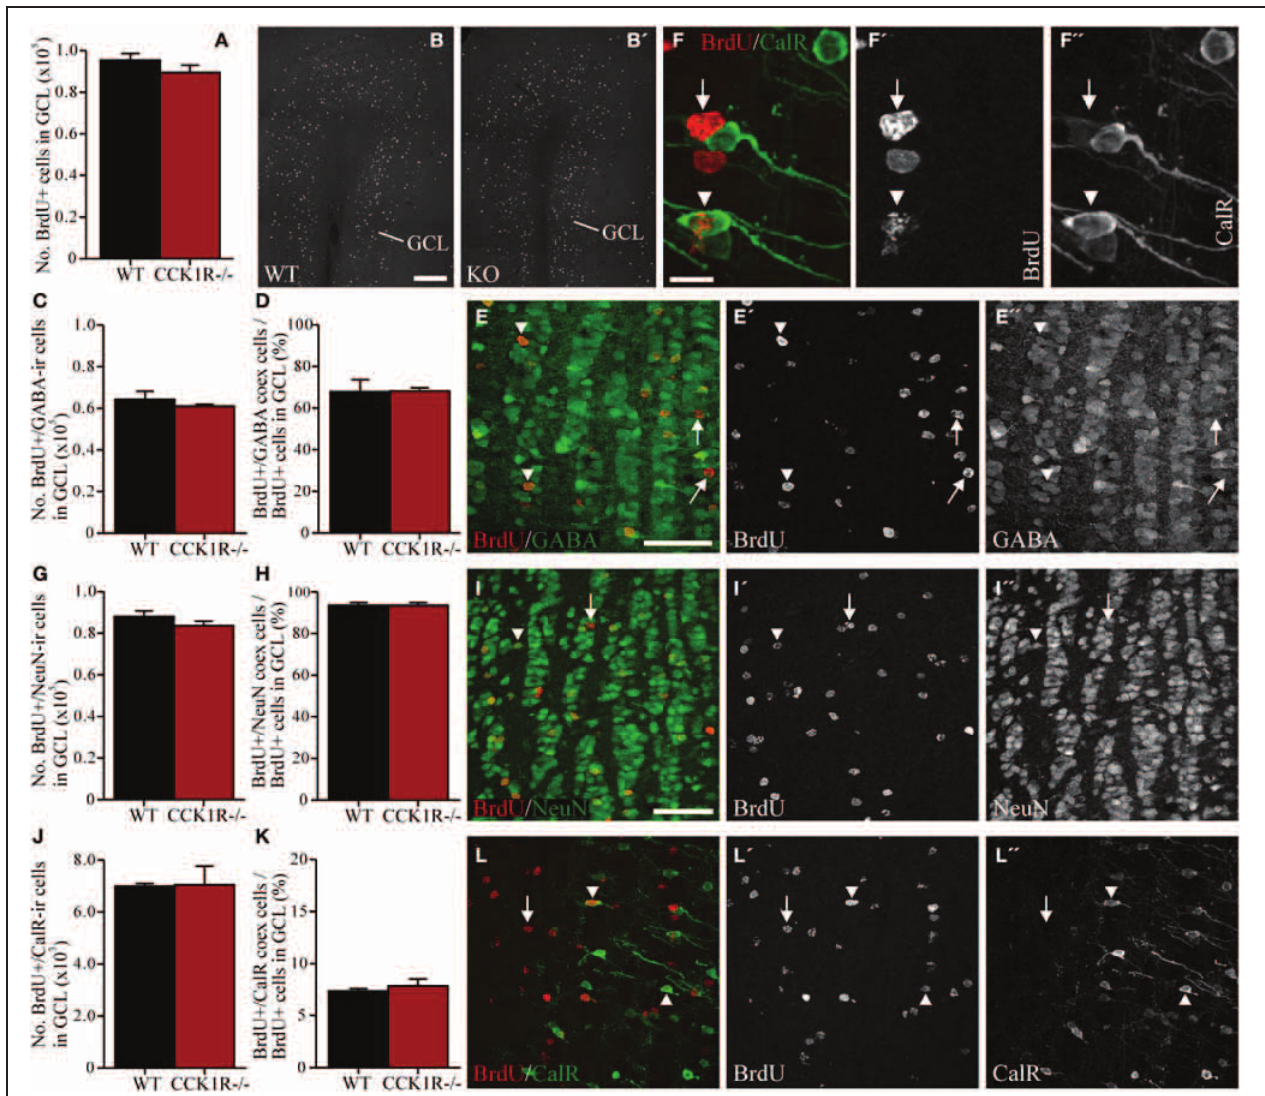
(I) Double-immunofluorescence confocal micrograph showing BrdU-LI ( I (cid:3) , red) and NeuN-LI ( I (cid:3)(cid:3) , green) in the GCL of CCK1R − / − mouse. (J–L,F) Estimated number of BrdU + and calretinin-ir double-labeled cell bodies in the GCL of wild-type and CCK1R − / − mice (J) . (K) Estimated number of BrdU + /calretinin-ir co-expressing cell bodies expressed as a proportion of the total number of BrdU + cell bodies in the GCL of wild-type and CCK1R − / − mice. (L) Double-immunofluorescence confocal micrograph showing BrdU-LI ( L (cid:3) , red) and calretinin-LI ( L (cid:3)(cid:3) , green) in the GCL of CCK1R − / − mouse, shown at higher magnification in (F), (F (cid:3) ) , and (F (cid:3)(cid:3) ) , respectively. In all plots, black bars = female wild-type animals ( n = 4), and red bars = female CCK1R − / − mice ( n = 4). Arrowheads point to double-labeled cell bodies, and arrows to single labeled BrdU + cell bodies. BrdU, 5-bromo-2-deoxyuridine; CalR, calretinin; GABA, γ -aminobutyric acid; GCL, granular cell layer of OB; ir, immunoreactive; KO, CCK1R − / − ; NeuN, neuronal nuclei; WT, wild-type; + , positive. Scale bars: (B) = 200 μ m, applies (B,B (cid:3) ) ; (E) = 50 μ m, applies (E,E (cid:3) ,E (cid:3)(cid:3) ) ; (F) = 10 μ m, applies (F,F (cid:3) ,F (cid:3)(cid:3) ) ; (I) = 50 μ m, applies (I,I (cid:3) ,I (cid:3)(cid:3) ,L,L (cid:3) ,L (cid:3)(cid:3) )